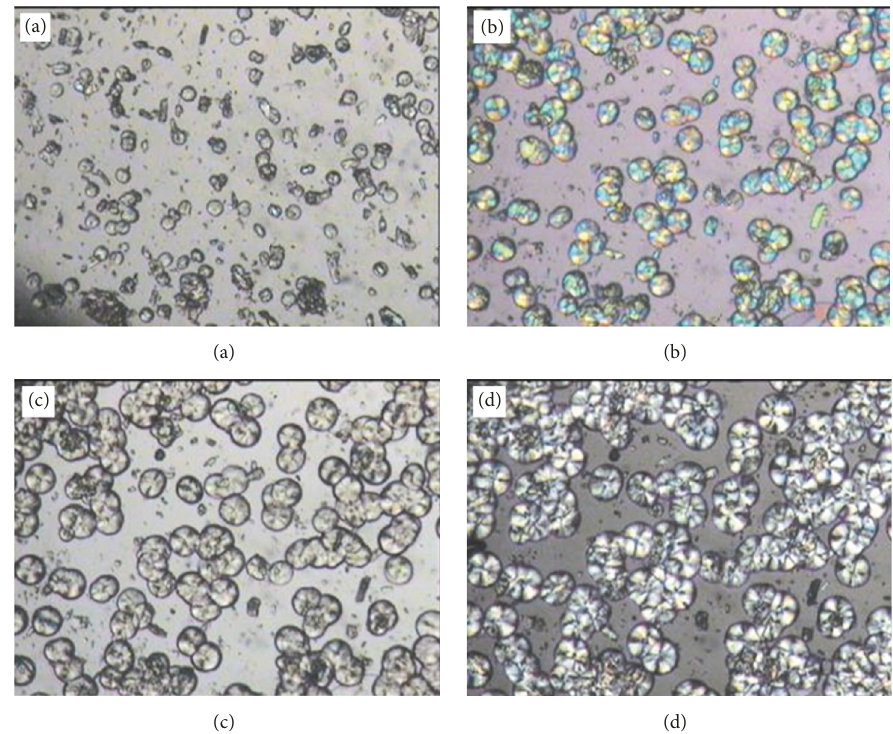
Figure 16: Isothermal crystallization images at 145 ∘ C for 95 wt% PP/5wt% MCC nanoclay composite after (a) 5 minutes, (b) 10 minutes, (c) 20 minutes, and (d) 30 minutes [magnification = 133x].